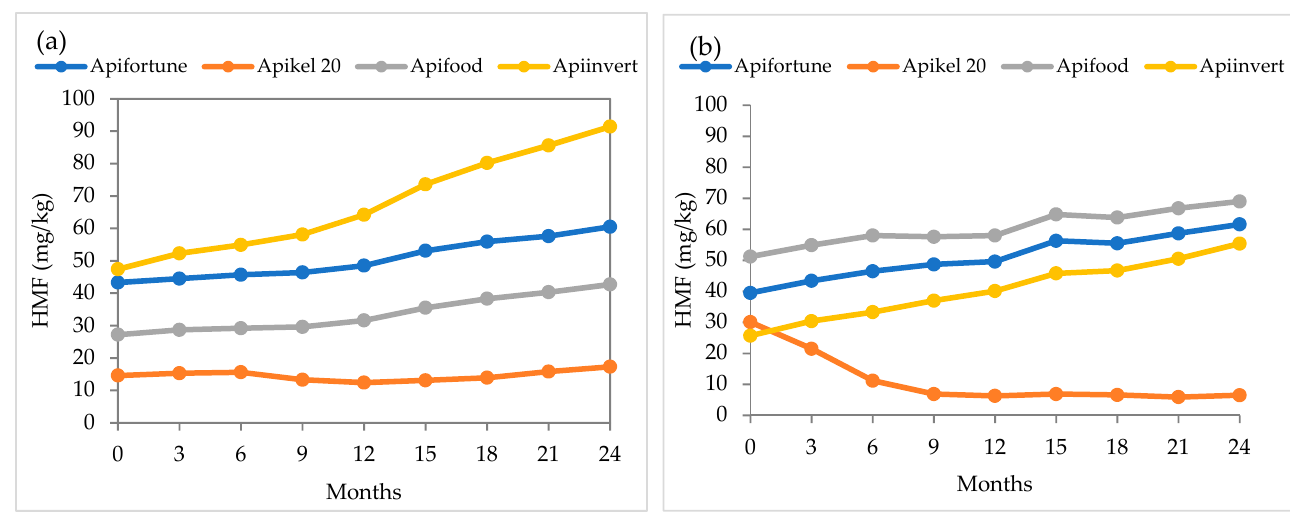
Figure 1. Changes of HMF content in syrups during storage at about 20 °C ( a ) from 2012 and ( b ) from 2013.